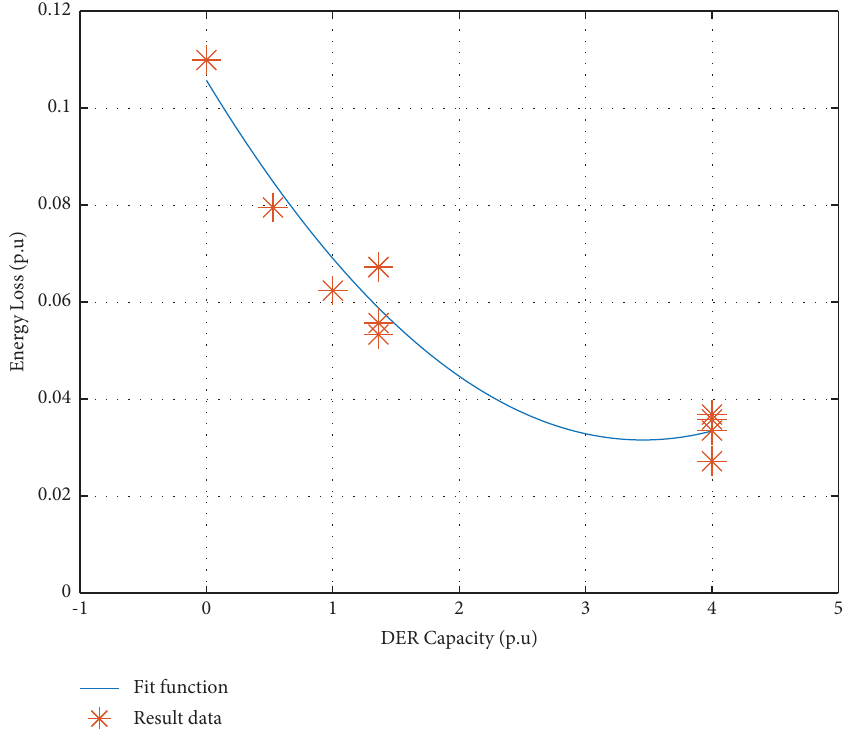
Figure 7: Power balance for simulation 4D.